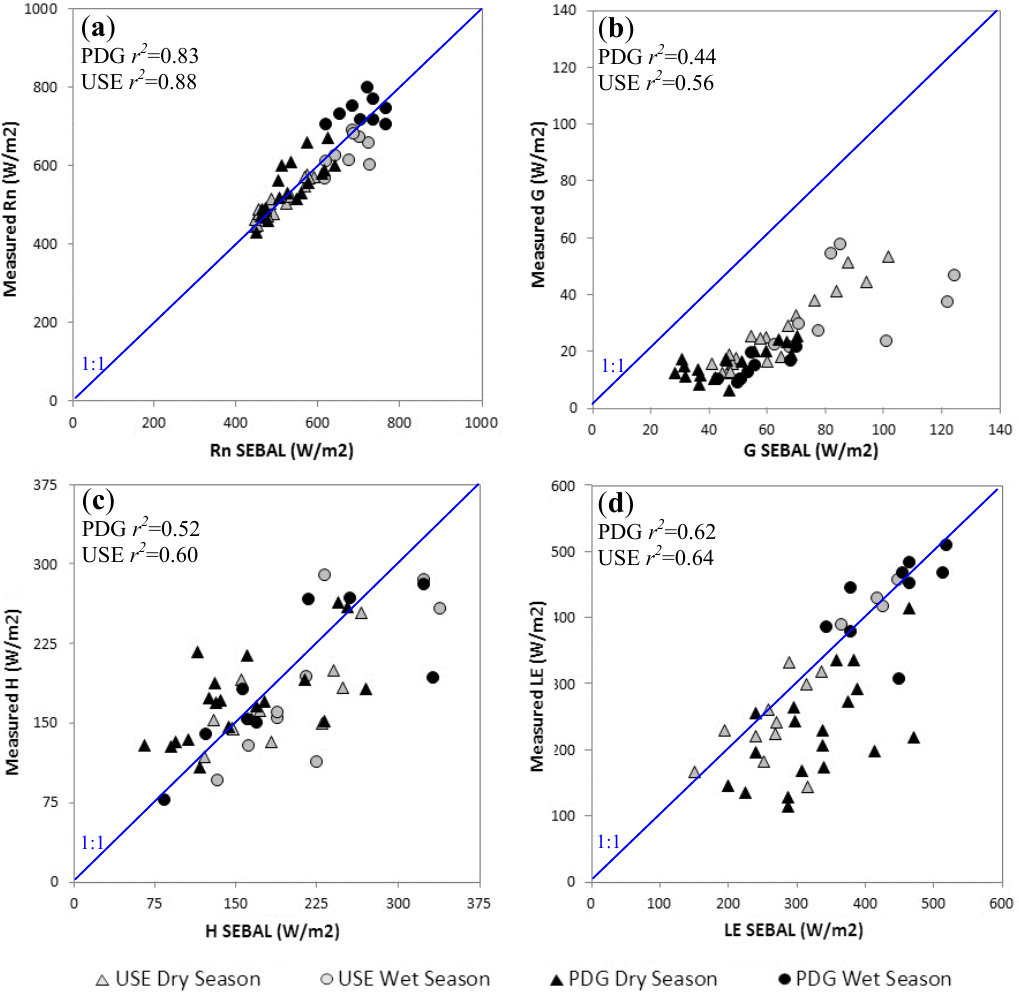
Figure 2. Comparison between instantaneous on-overpass (11:30am LT) energy fluxes estimated using SEBAL and in situ measured data over savannas (PDG site) and sugarcane croplands (USE site). Labels: Net radiation ( a ), soil heat flux ( b ), sensible heat flux ( c ) and latent heat flux ( d